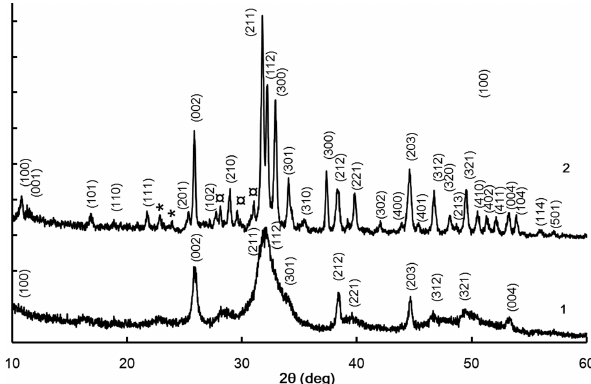
Figure 2: XRD patterns for hydroxyapatite obtained by sol-gel method (1) and solid-state reaction (2). ∗ - cuvette reflections, ¤ - β -tricalcium phosphate reflections.